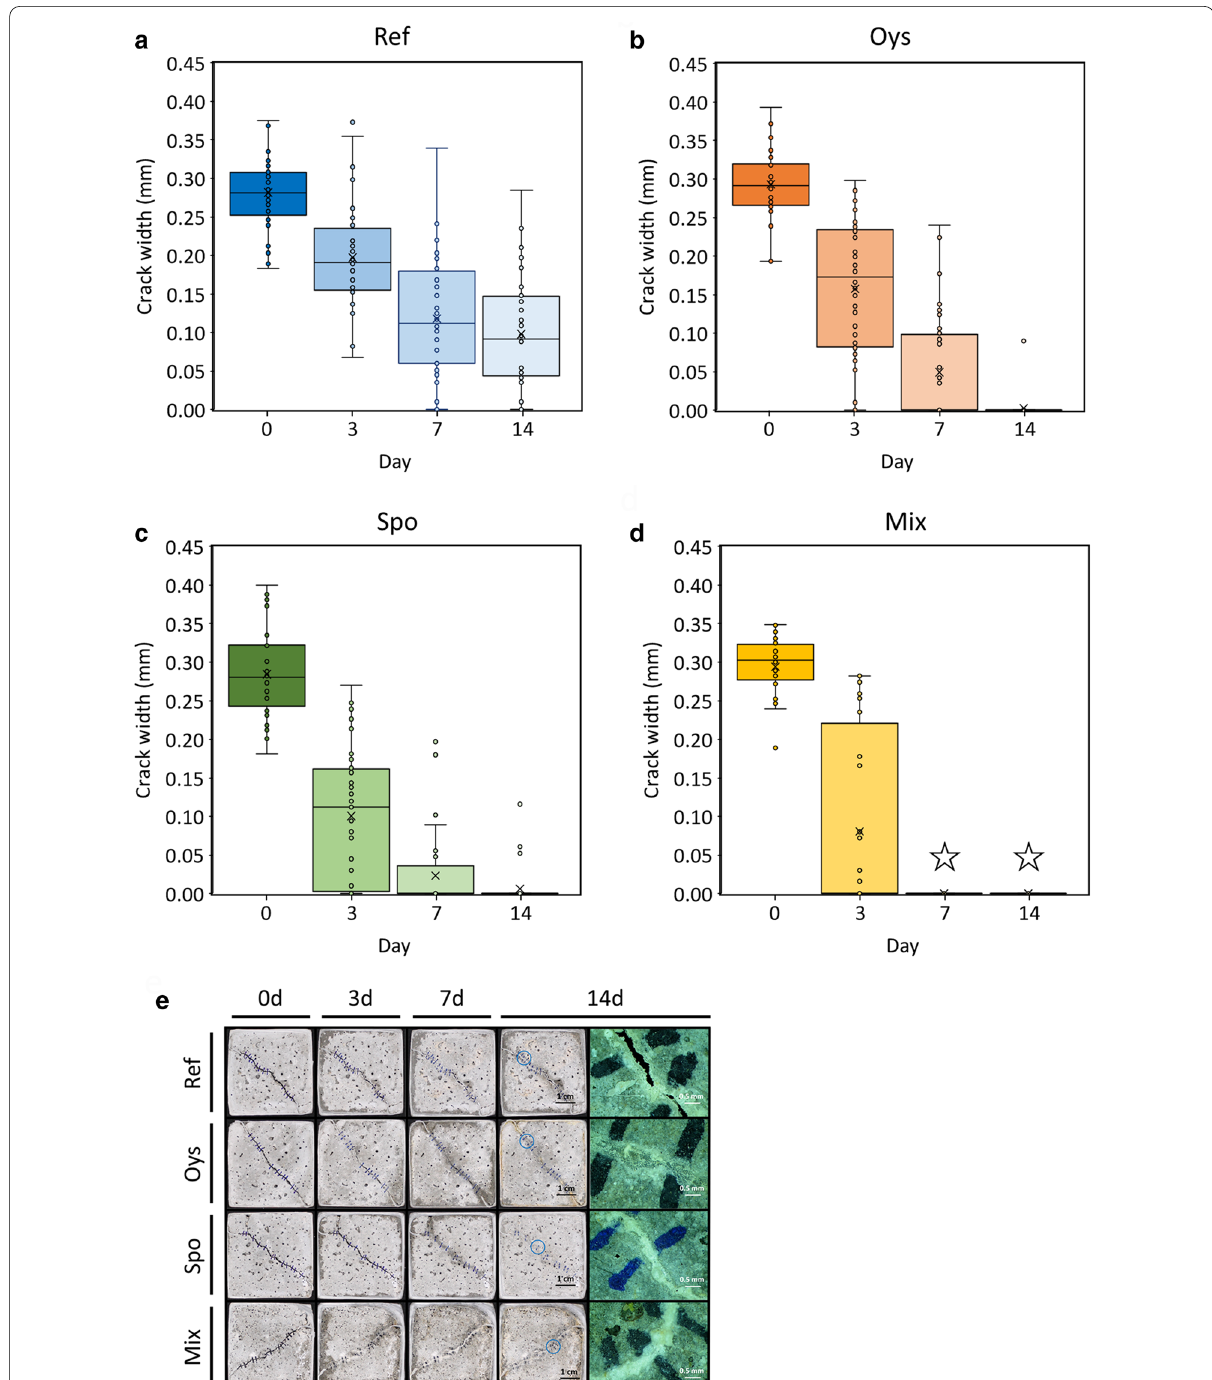
Fig. 6 Measurement of crack-healing rates of mortar specimens treated with SN. a – d The decreasing crack width in specimens treated with SN once a day. An asterisk ( ☆ ) indicates cracks that were healed completely. e Progression of calcium carbonate precipitation in cracks with daily SN